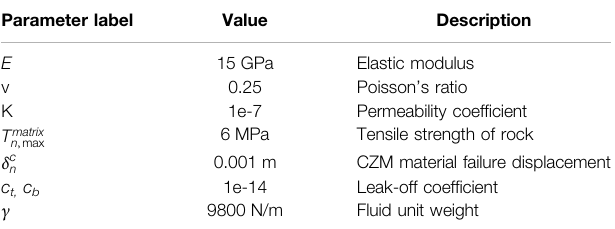
TABLE 2 | Model constant parameters used in